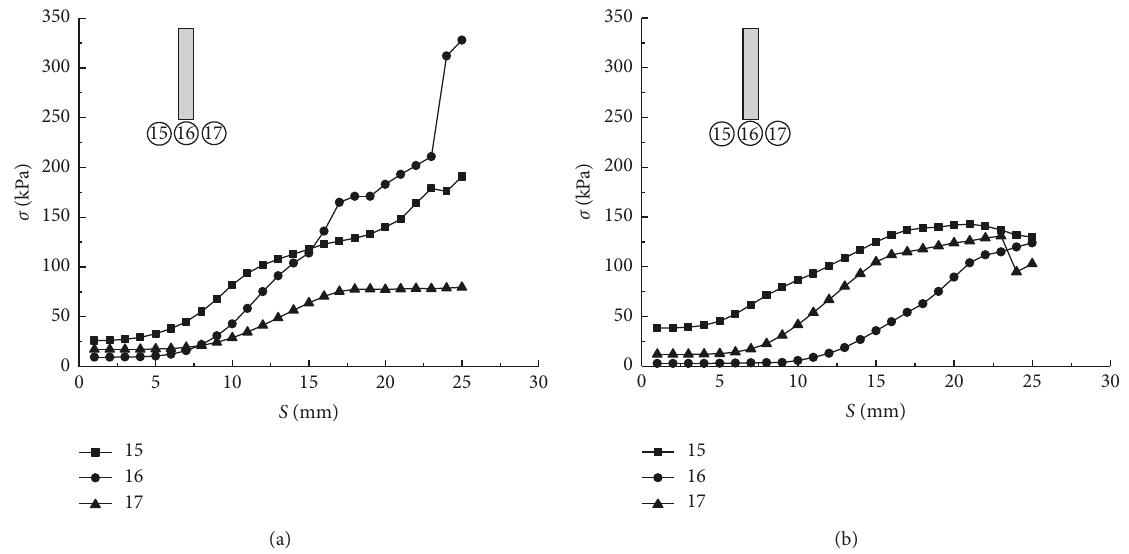
Figure 19: Sand vertical stress distribution beneath the pile tip. (a) 3 b pile spacing. (b) 6 b pile